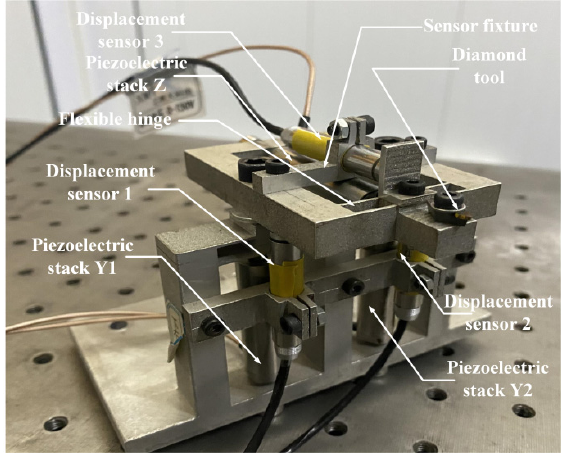
Figure 1. The structure of the 3D-EVC system.